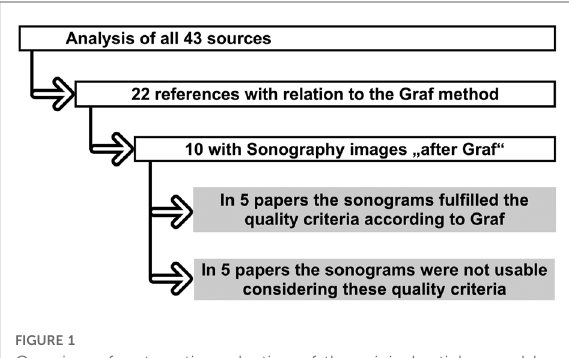
FIGURE 1 Overview of systematic evaluation of the original articles used by Sakkers et al. (3). 10 articles included sonograms, only 5 articles ful fi lled the quality criteria according to Graf.